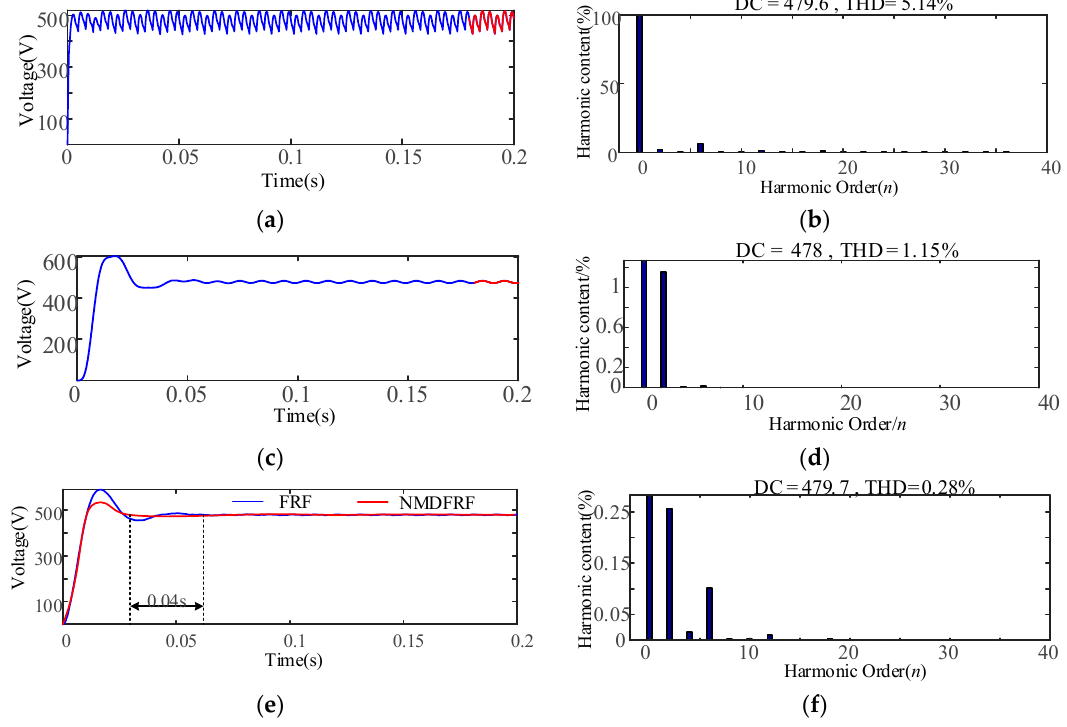
Figure 19. Comparison of the filtering performances for different filters. ( a , b ) TF; ( c , d ) FRF; ( e , f ) DNMFRF.